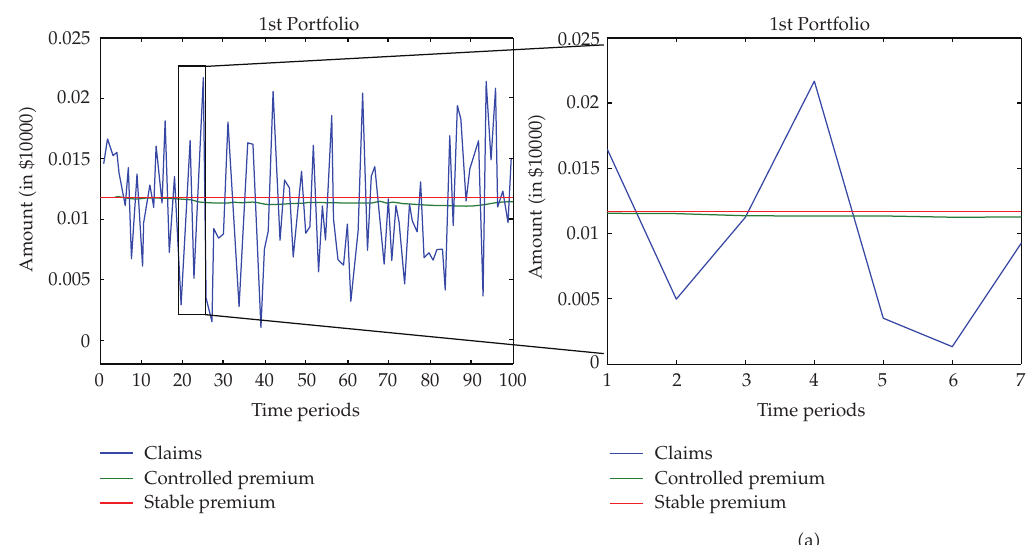
Figure 1: 1st class of a heterogeneous Portfolio, during 100 unit-time period (cid:5) an enlargement region, where the results are more clear (cid:7) .